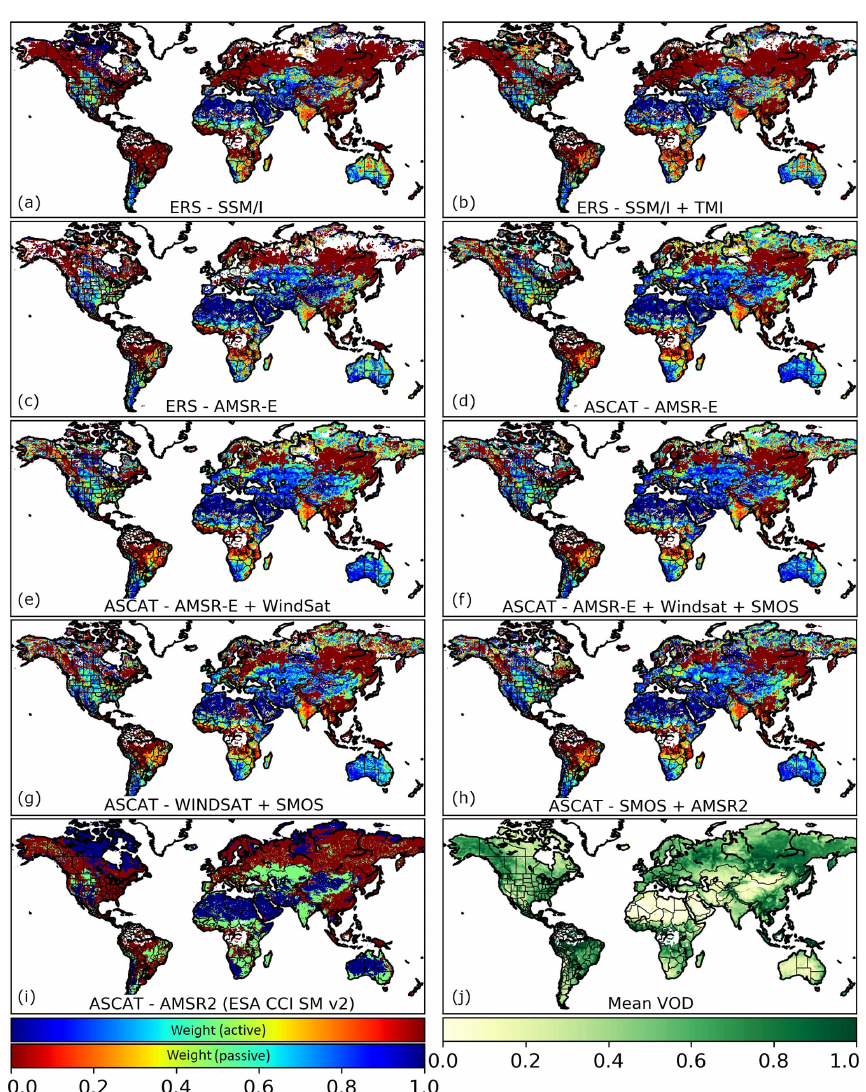
Figure 4. Weights for merging the ACTIVE and PASSIVE products in the ESA CCI SM v3 algorithm (all sensor periods, a – h ), weights for merging the ACTIVE and PASSIVE products in the ESA CCI SM v2 algorithm (latest period, i ) and average VOD derived from AMSR-E (j) .